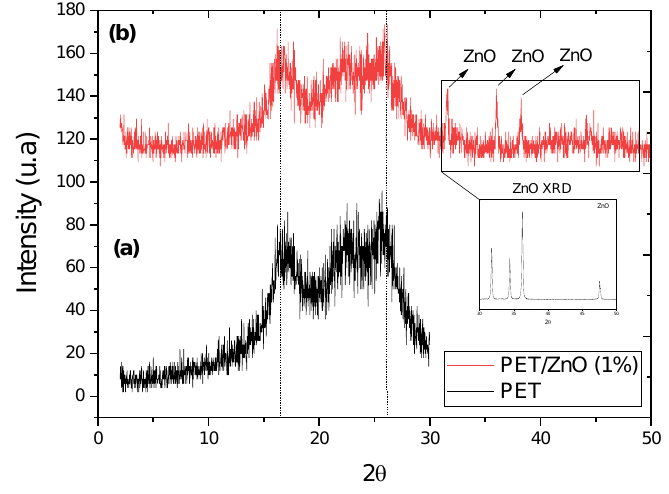
Figure 2. X-ray diffractograms of PET ( a ) and PET/ZnO 1% ( b ). Figure 2. X-ray di ff ractograms of PET ( a ) and PET / ZnO 1% ( b